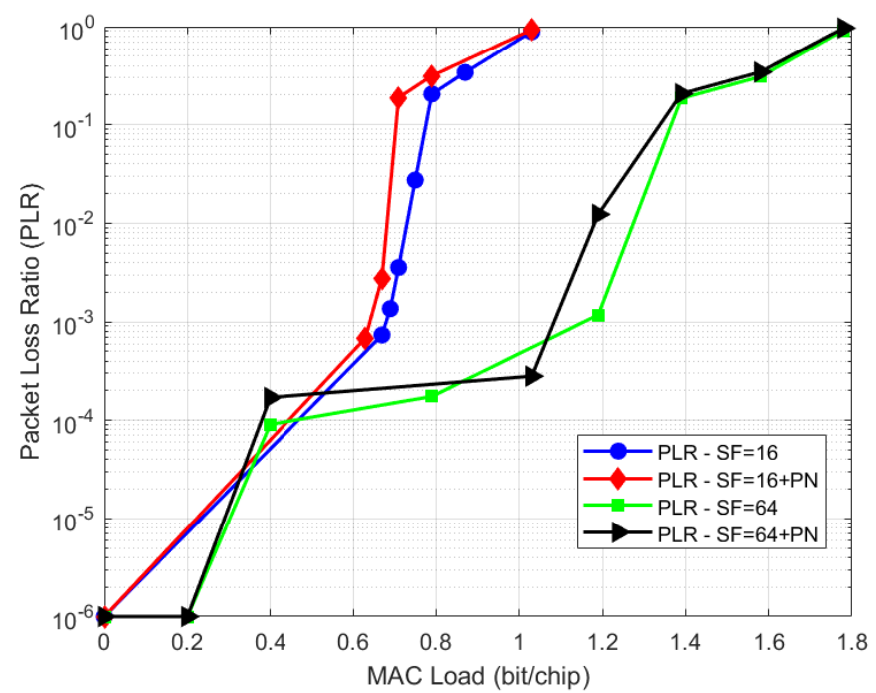
Figure 5. UC#1: F-SIM PLR performance. Table 1. UC#1: F-SIM results.